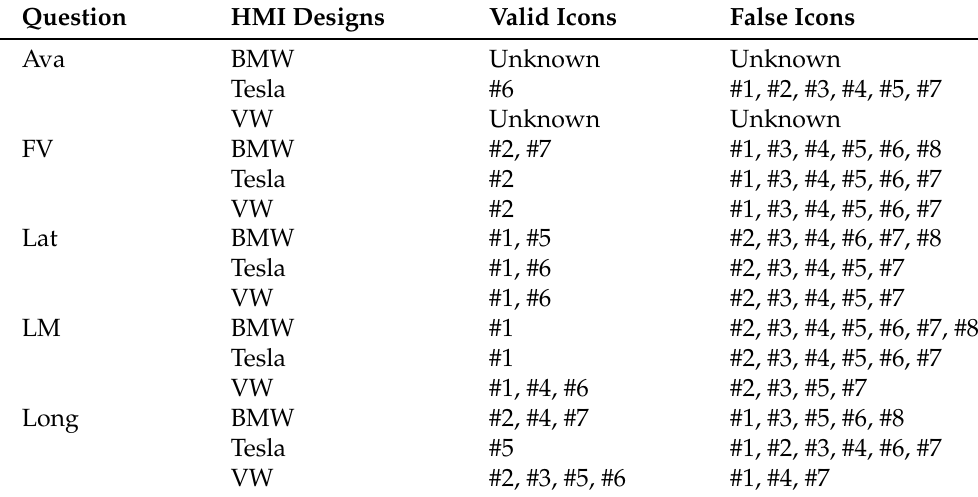
Table 5. Valid and false icons on HMI designs concerning TRASS question